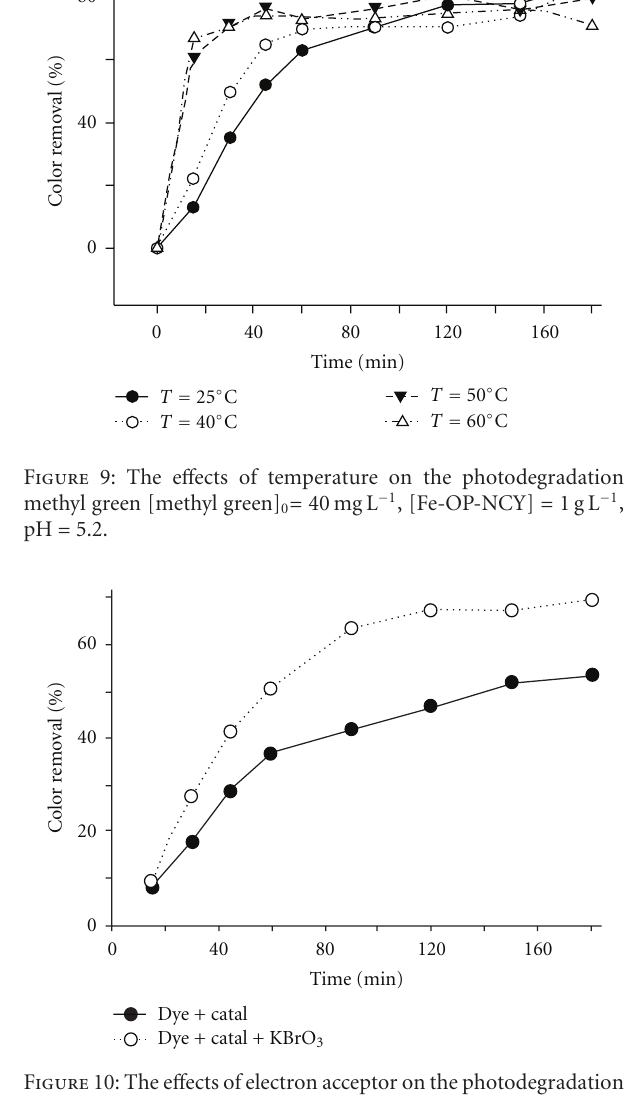
Figure 10: The e ff ects of electron acceptor on the photodegradation methyl green [methyl green] 0 = 40 mgL − 1 , [Fe-OP-NCY] = 1gL − 1 , pH = 5.2, [KBrO 3 ] = 20mgL − 1